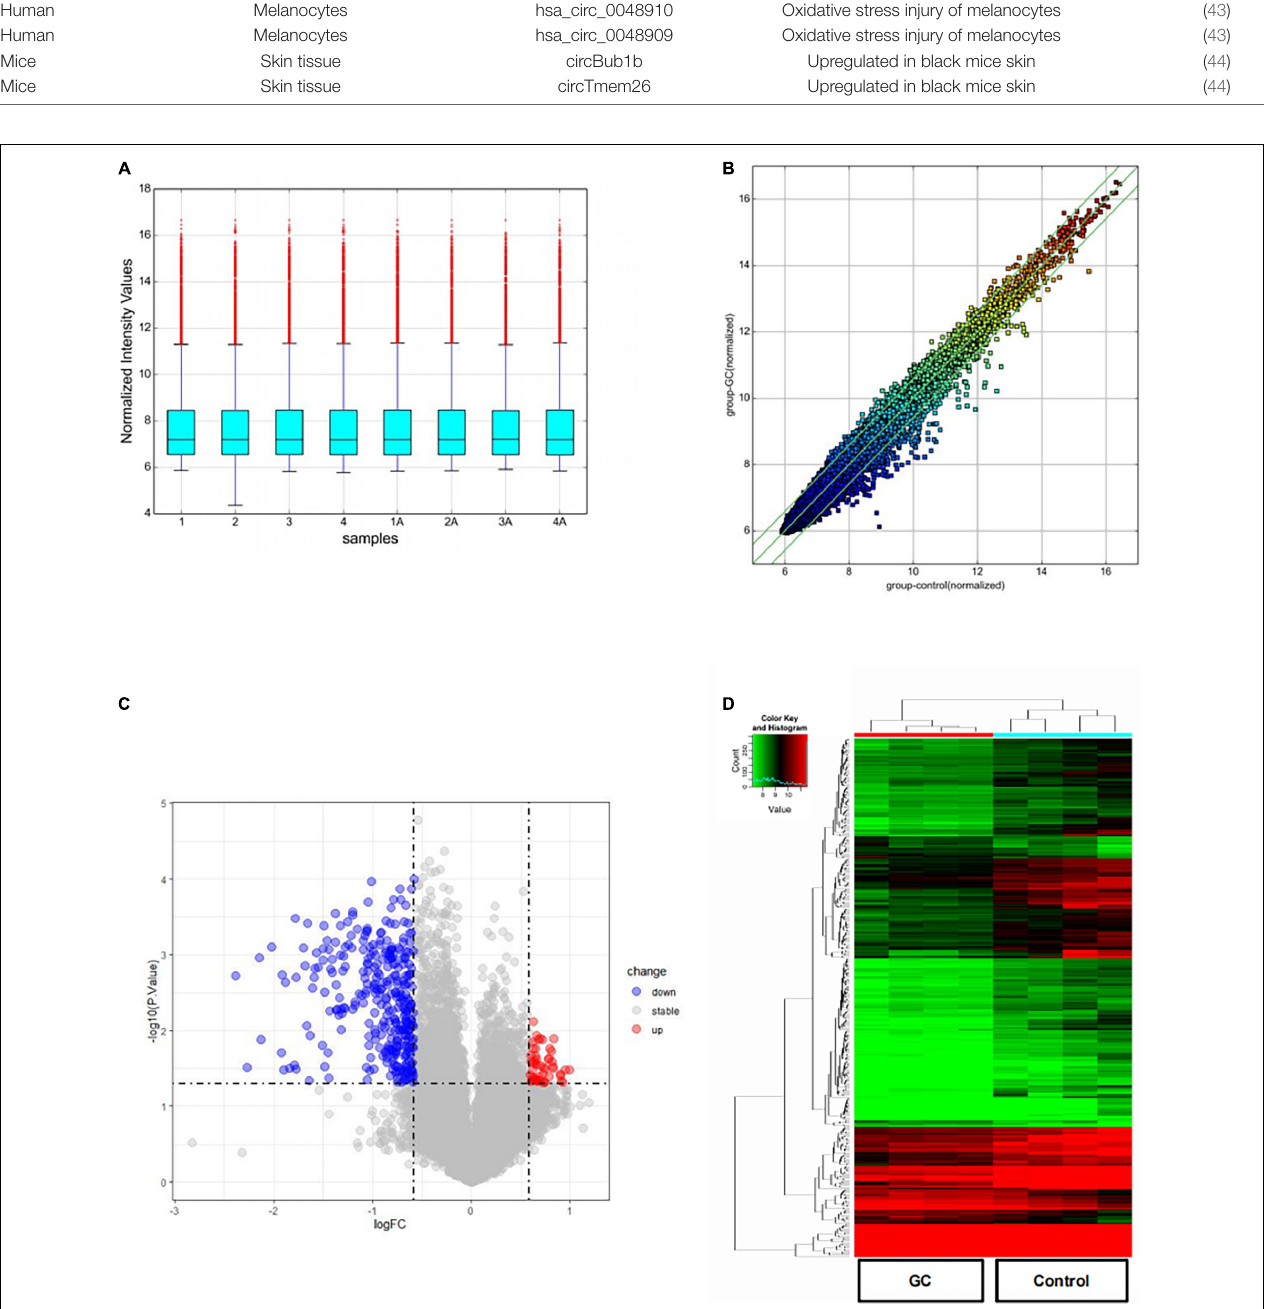
FIGURE 1 | DEcircRNAs in patients with vitiligo before and after systemic glucocorticoid therapy. (A) A box plot shows the distribution of expression data in each sample after quantile normalization. (B) Scatter plot was performed to evaluate the centralized tendency of chip data in two different groups. (C) Volcano plot of the P -value as a function of weighted fold change for DEcircRNAs (DEcircRNAs) (fold change > 1.5, P < 0.05). (D) Heat map for potential DEcircRNAs ( n = 375) shows 51 upregulated and 324 downregulated.